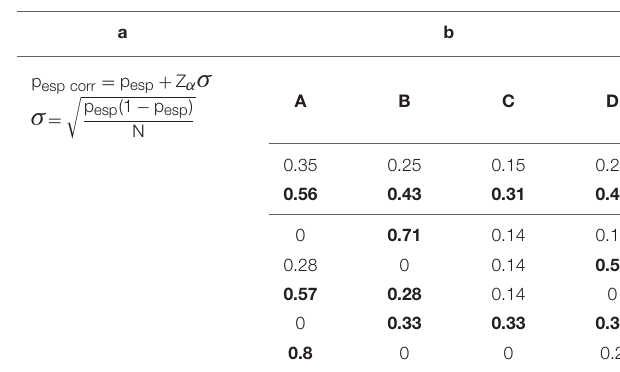
TABLE 6 | (a) Formula for calculating the corrected unconditional (expected) probability. (b) Table showing the probabilities from Table 5b with the addition of the corrected conditional probabilities in the second row (bold